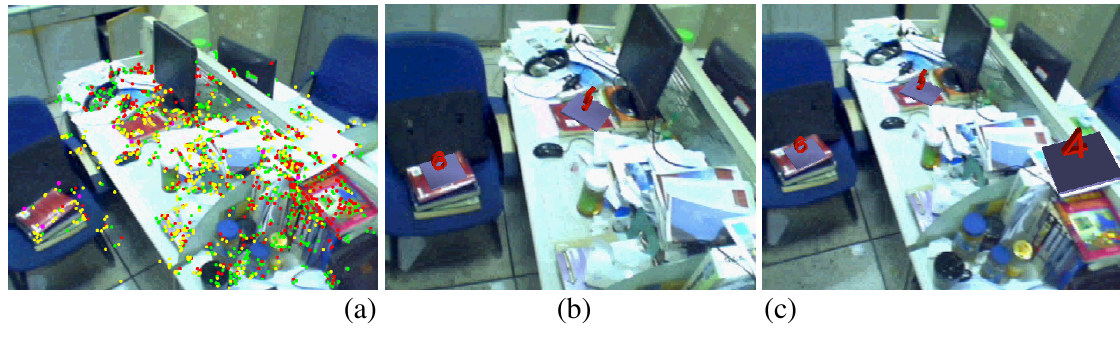
Figure 8. Multiple maps tracking